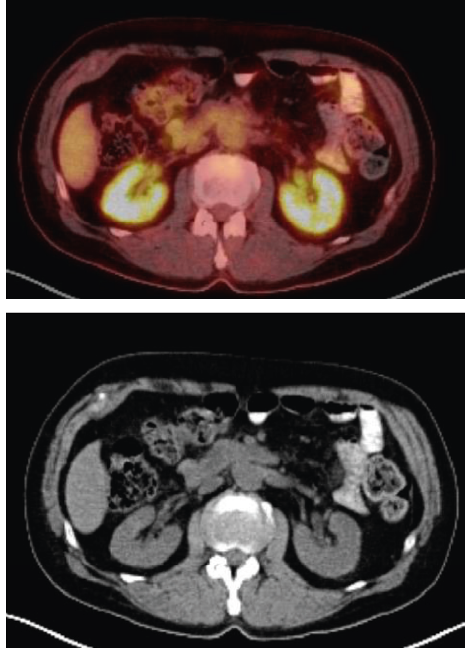
Figure 2: Diffuse symmetric fluorodeoxyglucose (FDG) uptake within the bilateral renal parenchyma on positron emission to- mography-computed tomography (PET-CT)